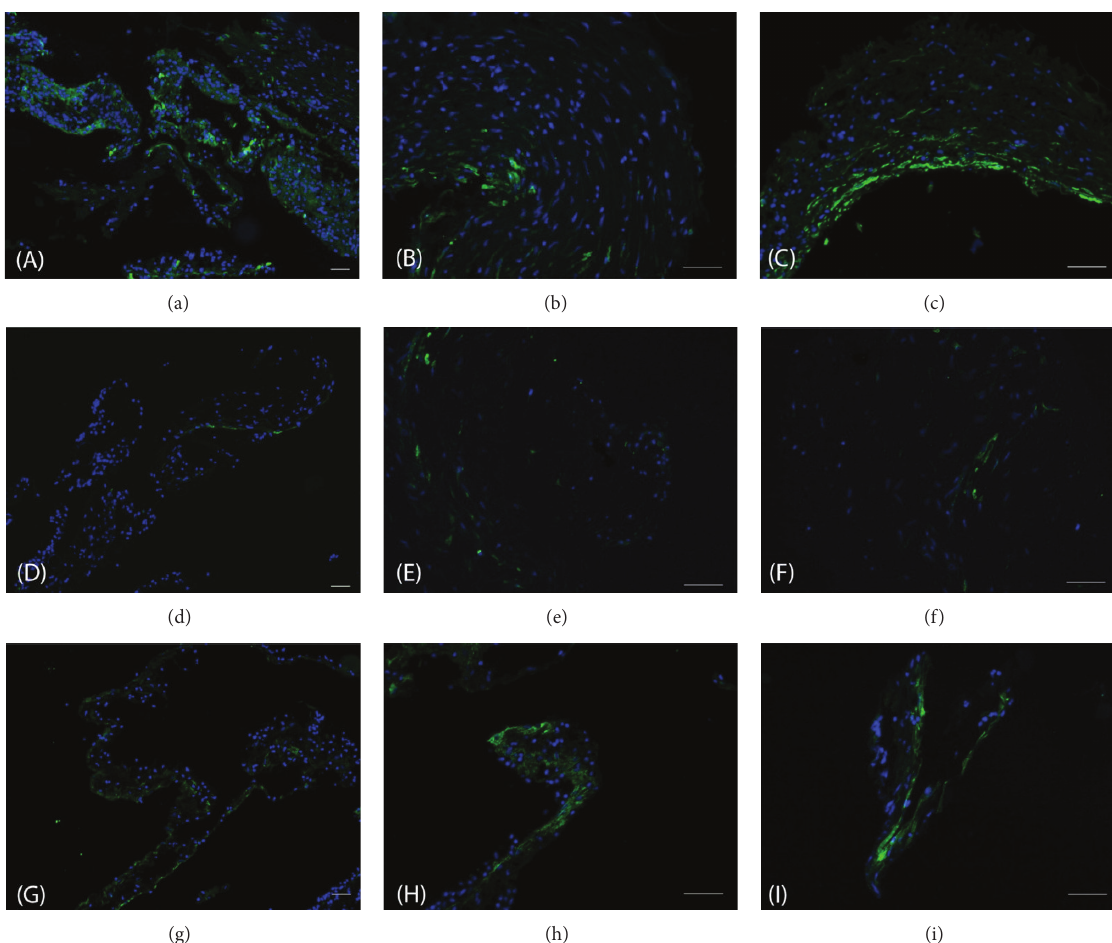
Figure 2: AQP1 expression in membranes from PVR and ERM. Images presented in each row represent different areas of the same membrane. (a–c) PVR number 1, (d–f) PVR number 2, and (e–g) ERM. AQP1 was immunolabelled in green, while cell nuclei were stained in blue with DAPI. Scale bars represent 50 𝜇